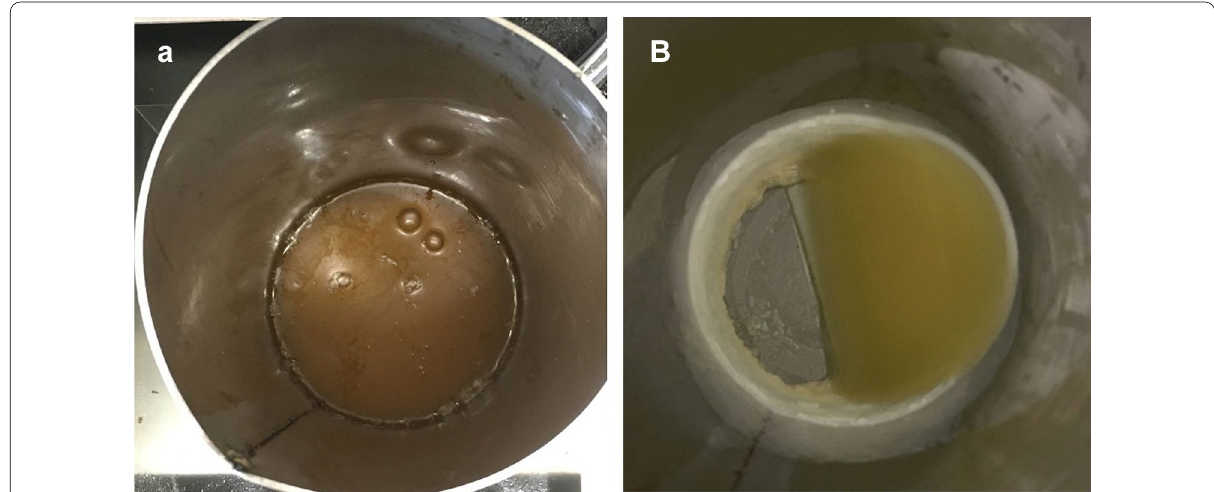
Fig. 3 a Sample solution before SAC method and b solidified free glycerol attached on vessel surface, and pure biodiesel remained in liquid phase after